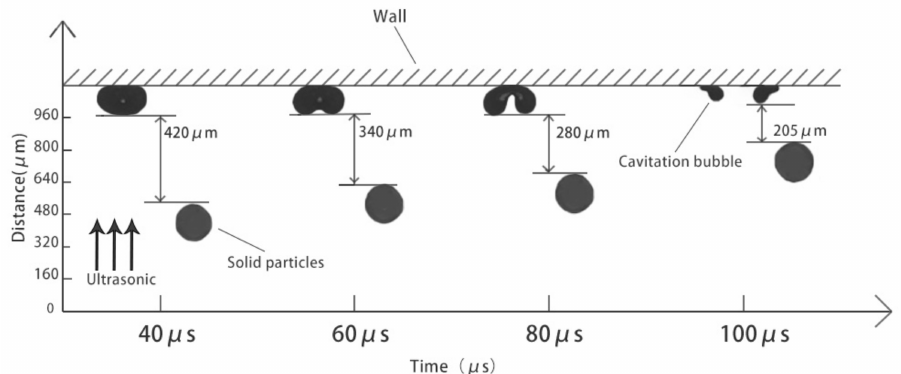
Figure 10. The relative distance between the bubbles and particles in the microfluidic channel when ultrasonic waves are applied.